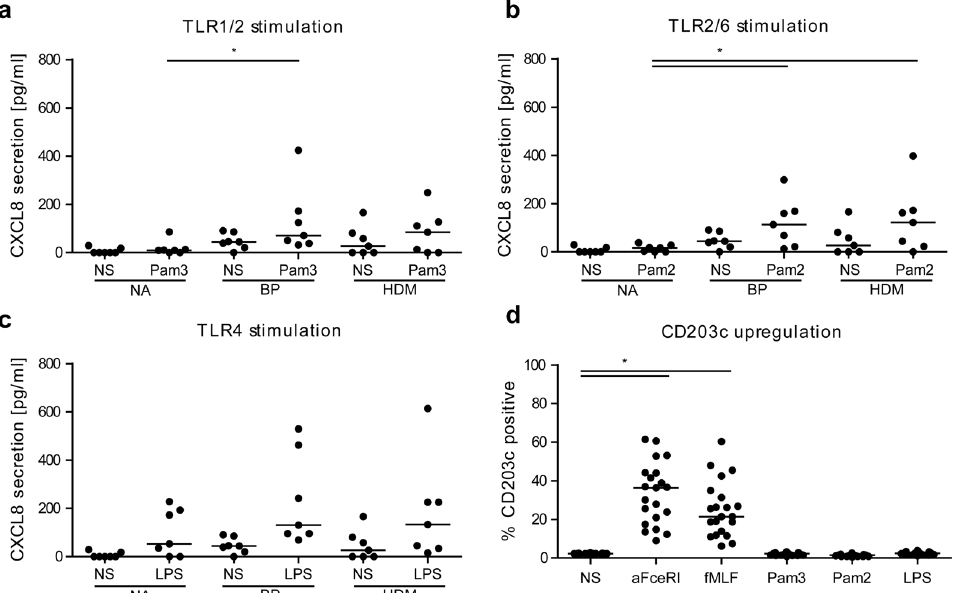
Fig 4. CXCL8 secretion and CD203c expression of purified human basophils of non-allergic (NA), birch pollen (BP)-allergic, and house dust mite (HDM)-allergic donors (n = 7, each). Stimulation of TLR1/2 with Pam 3 CSK 4 ( a ), of TLR2/6 with Pam 2 CSK 4 ( b ) and of TLR4 with LPS ( c ). ( d ), CD203c expression of all donors (n = 21); upon stimulation with positive controls (anti-Fc ε RI, fMLF) and the three TLR ligands (Pam 3 CSK 4 , Pam 2 CSK 4 , and LPS). Group comparisons were performed by two-way repeated measures ANOVA (a, b, c) with Bonferroni ’ s post hoc test and Kruskal-Wallis test with Dunn ’ s post hoc test (d). Bars represent medians. NS, non-stimulated; * , p < 0.05.